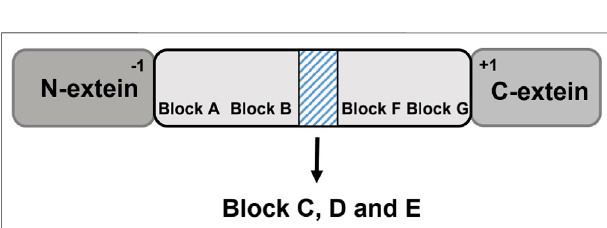
FIGURE 2 | Conservative motifs of inteins facilitate protein splicing. The motifsA-Gareidenti fi edintheinteindomain.BlockC,DandEarenotedinthe shadow box, where the split sites of naturally occurring split inteins and homing endonuclease domain (HED)are located.